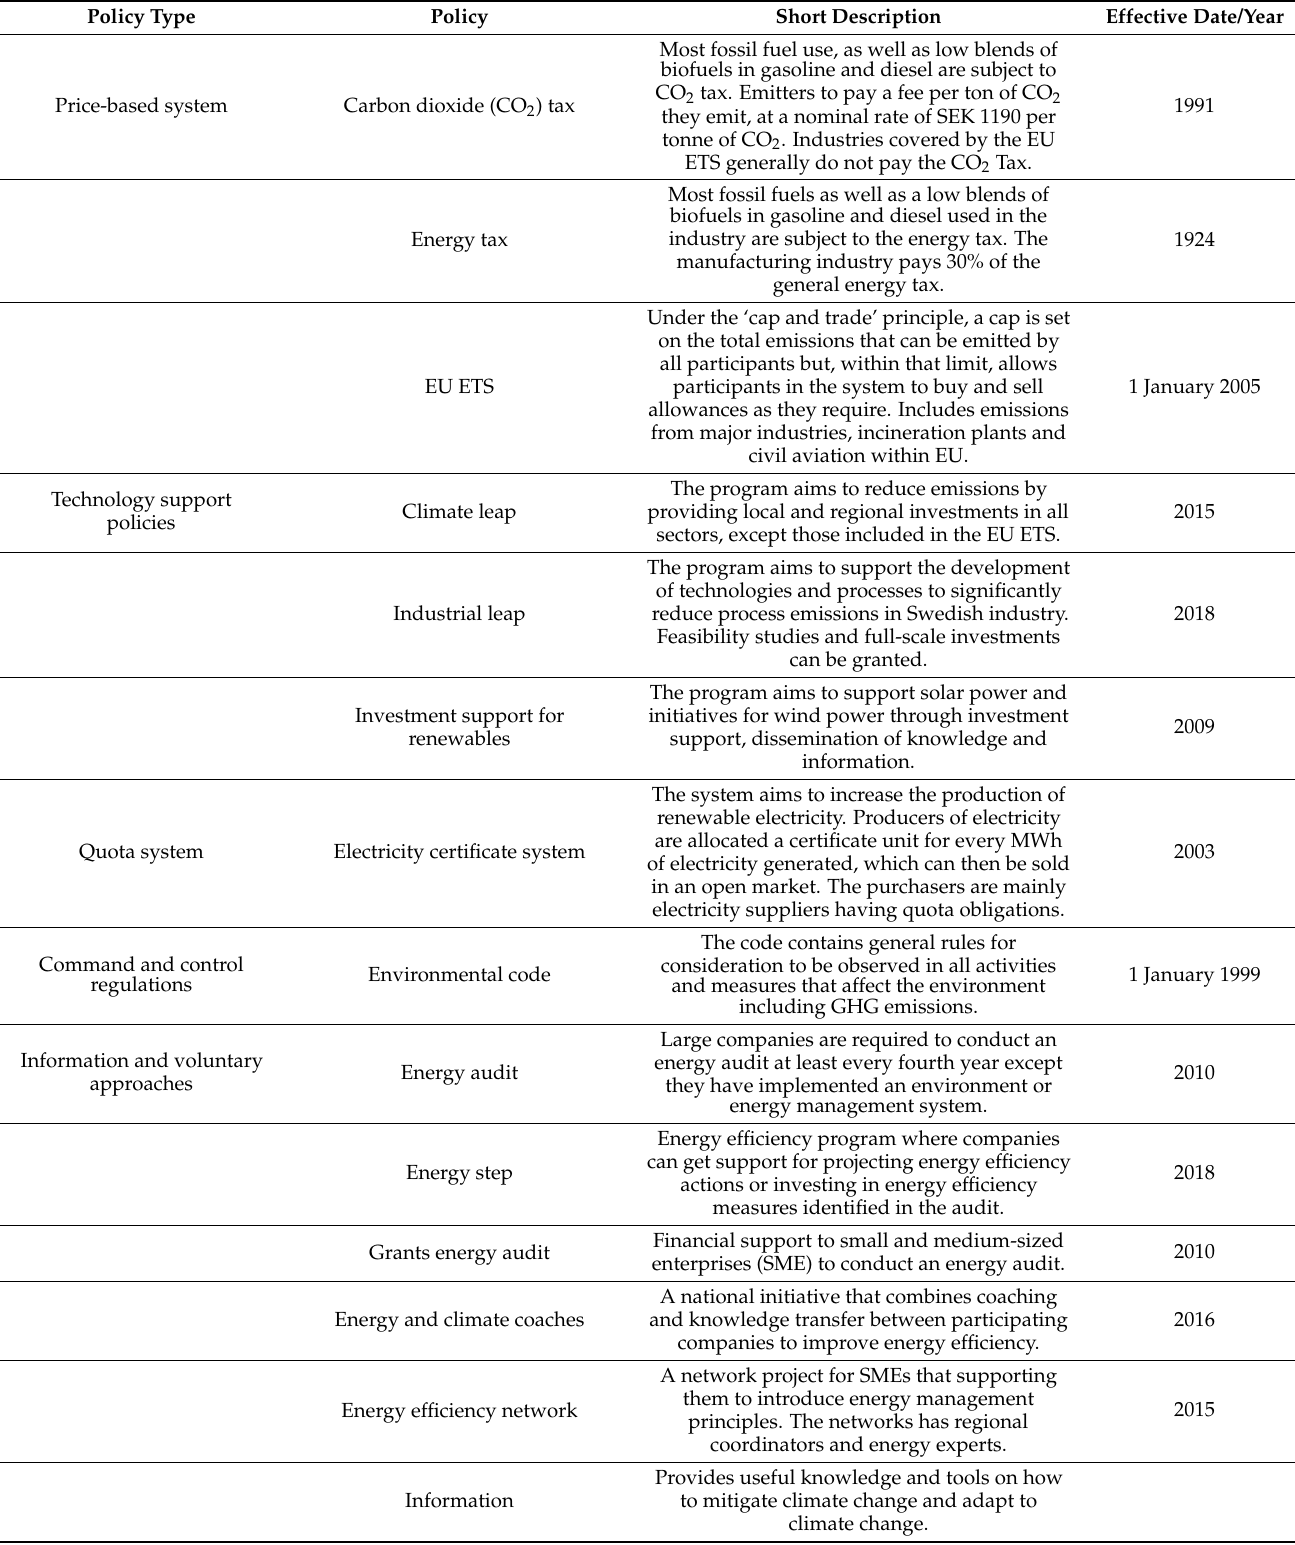
Table 6. Key policies related to industrial decarbonisation in